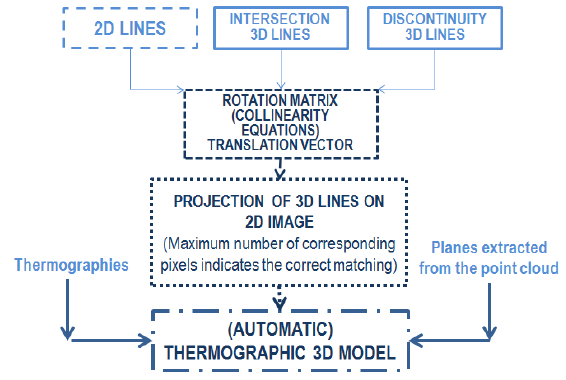
Figure 2. Workflow Part 2: calculation of the orientation parameters of a thermographic image with respect to a point cloud from extracted 3D and 2D lines.